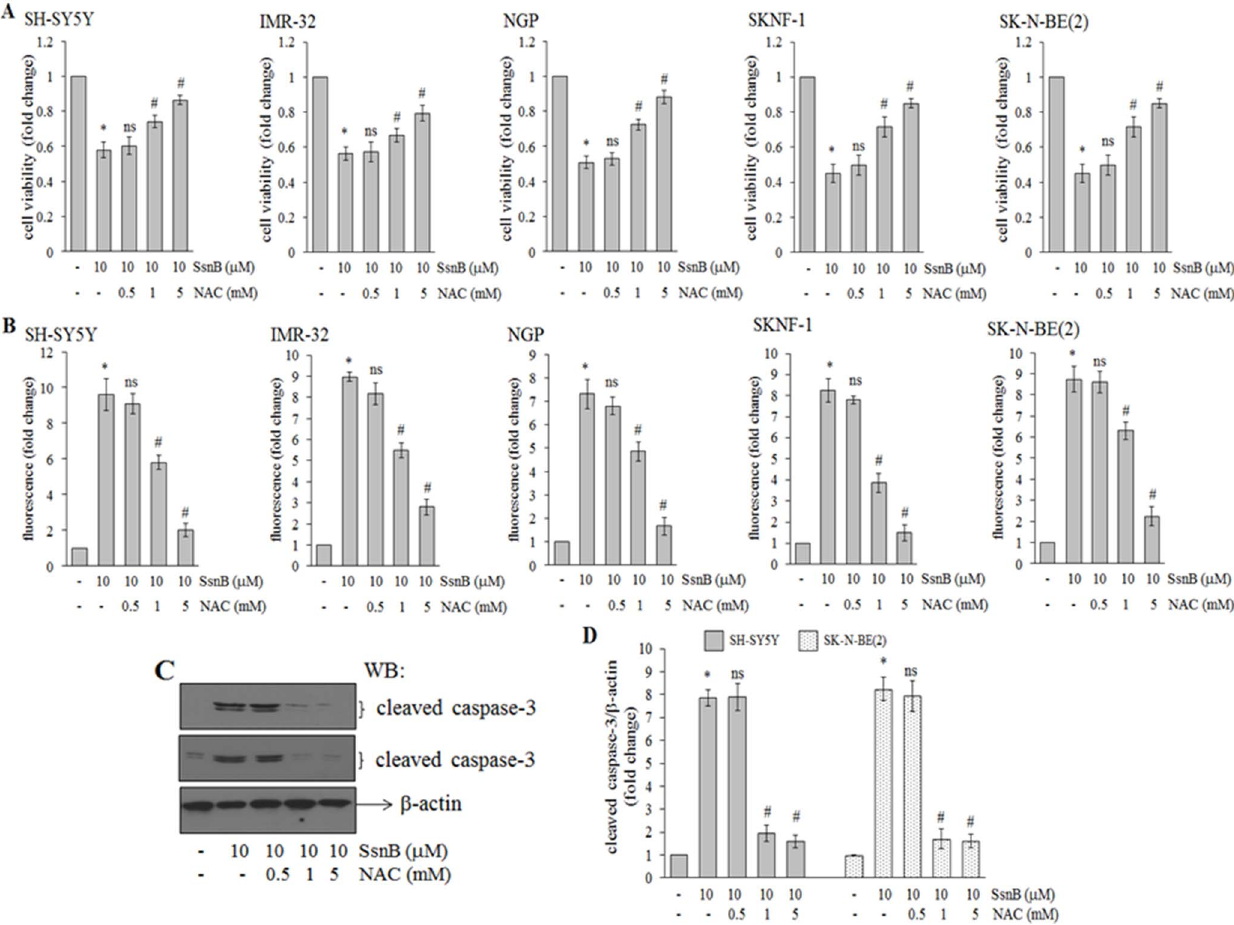
Figure 5. N-acetylcysteine (NAC) attenuates the inhibitory effects of SsnB. (A) Neuroblastoma cells were pretreated with NAC (0.5, 1 or 5 mM) for 1 h followed by SsnB (10 m M) treatment for 2 days (SH-SY5Y and IMR-32), 3 days (NGP) or 4 days (SKNF-1 and SK-N-BE(2) cells) and after treatments MTT cell viability assays was carried out. Bar represents mean and S.D. of three independent experiments and * p , 0.05 vs control; ns = nonsignificant vs SsnB 10 m M; # p , 0.05 vs SsnB 10 m M. ( B ) Bar diagram representing the fold change in H 2 DCFDA-fluorescence intensity in cells treated with SsnB (10 m M) alone or in combinations with NAC (0.5, 1 or 5 mM) as mentioned above. After labelling with H 2 DCFDA dye (25 m M) for 30 min fluorescence intensity was monitored at excitation wavelength 485 nm and emission wavelength 530 nm. Bar represents mean and S.D. of three independent experiments and * p , 0.05 vs control; ns = nonsignificant vs SsnB 10 m M; # p , 0.05 vs SsnB 10 m M. ( C ) Representative Western blots demonstrating level of cleaved caspase-3 in total cell protein isolated from SH-SY5Y (upper panel) and SK-N-BE(2) cells (lower panel) treated with NAC (0.5, 1 or 5 mM) and SsnB (10 m M) alone or in combinations for 2 days and 4 days, respectively. b -actin was used to check loading differences. Bar diagram represents the fold change in protein levels as measured by imageJ programme ( D ). Bar represents mean and S.D. of three independent experiments and * p , 0.05, SsnB 10 m M vs control; ns = nonsignificant vs control; # p , 0.05 vs SsnB 10 m M.